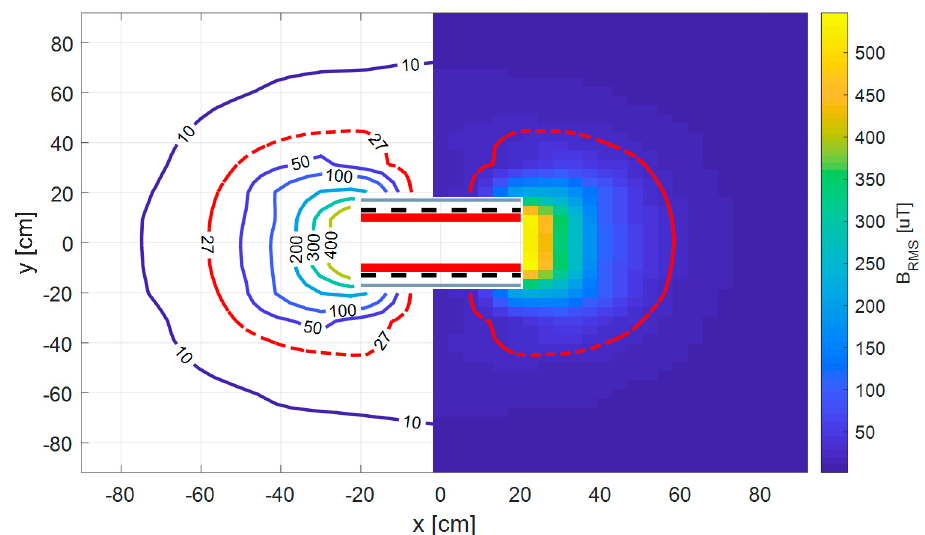
Figure 18. Magnetic field distribution around system of coils of experimental WChS prototype.